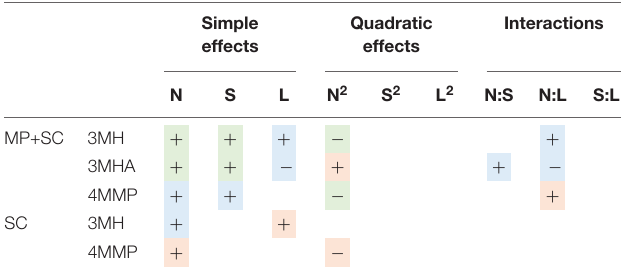
TABLE 7 | Effects of must parameters on the release of thiols by M. pulcherrima and S. cerevisiae under sequential inoculation (MP + SC) and S. cerevisiae in pure culture